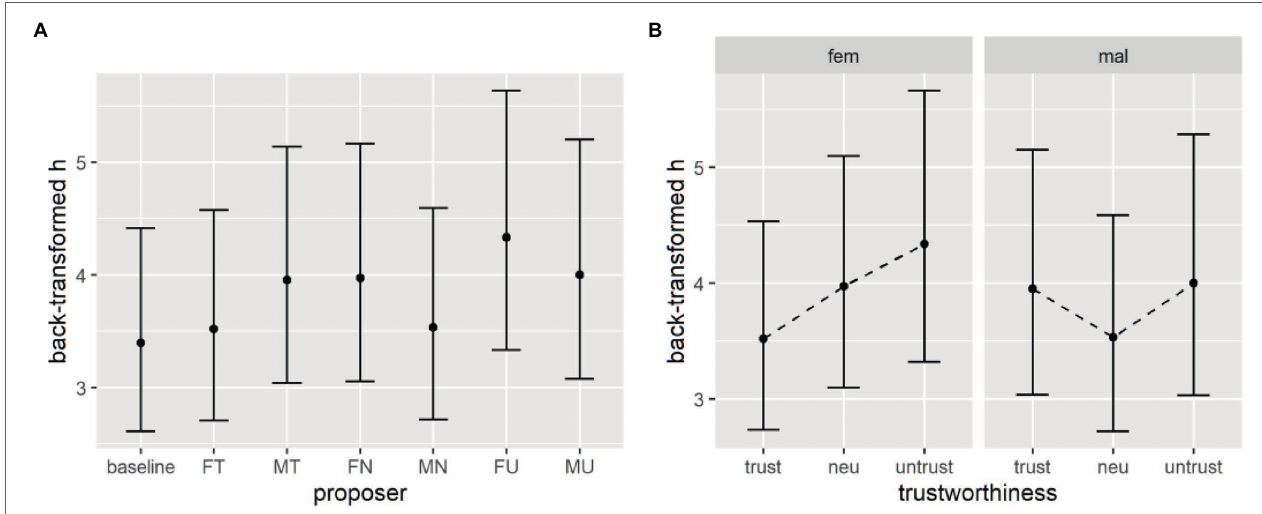
TABLE 8 | Fixed effects of proposer compared to baseline on RTs in the probability discounting task.